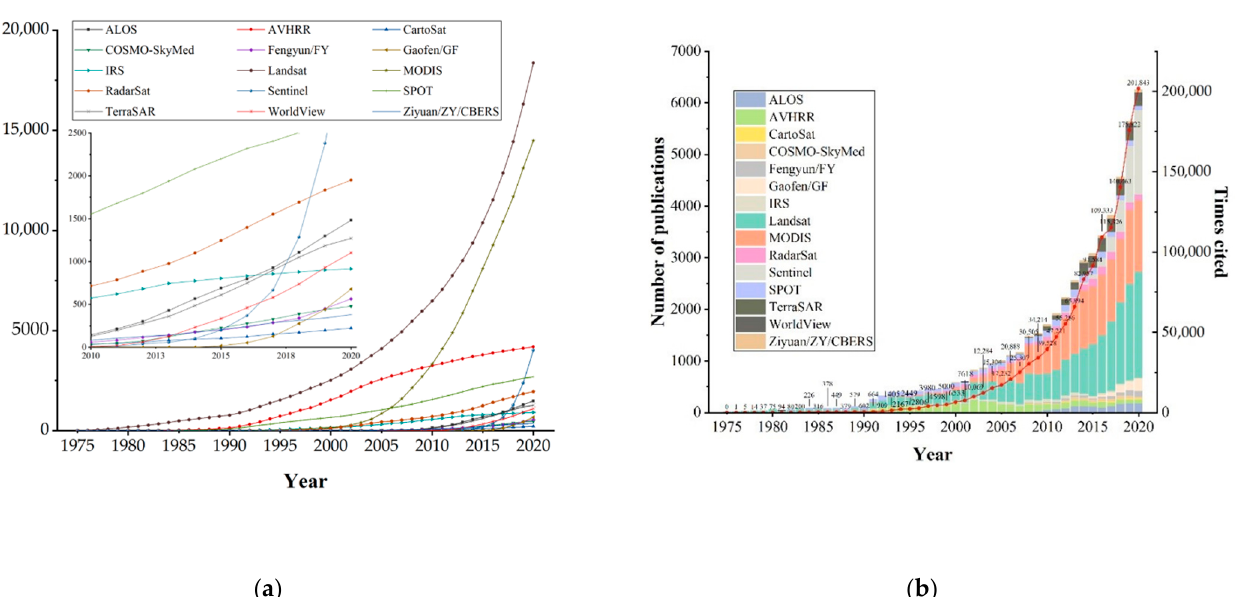
Figure 1. Number of ( a ) publications and ( b ) publications (bar) and citations (line) related to Earth observation satellites (the graphic inside is a zoom of dense area).